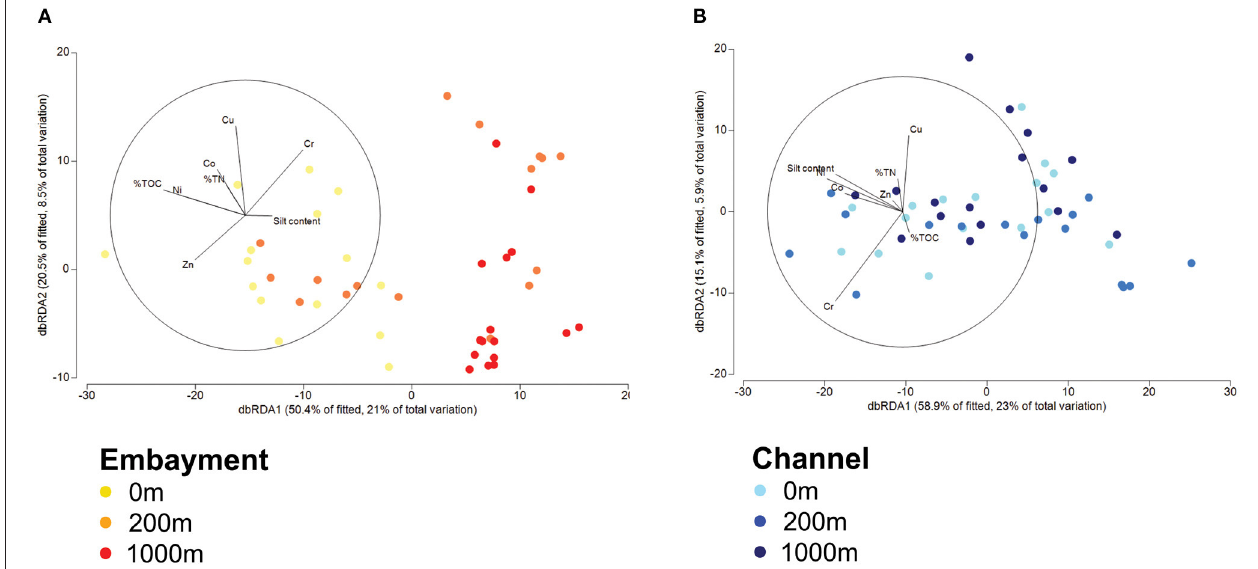
FIGURE 4 | Distance-based redundancy analysis (dbRDA) of bacterial communities in embayments (A) and channels (B) with regard to the distance from storm drains fitted to predictor variables. Ordination is colour-coded by site (proximity to storm drain) and retention type. Blue symbols are channel locations and orange symbols are embayment locations. The gradient in colour from lighter to darker represents the distances 0, 200, 1,000m from a storm drain. Lengths of vector overlays indicate the relative influences of fitted predictor variables.